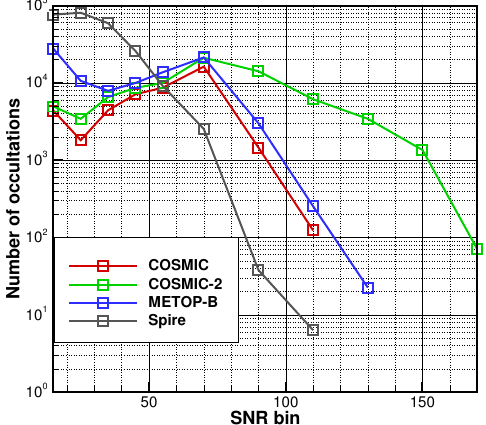
Figure 1. The number of occultations in the SNR